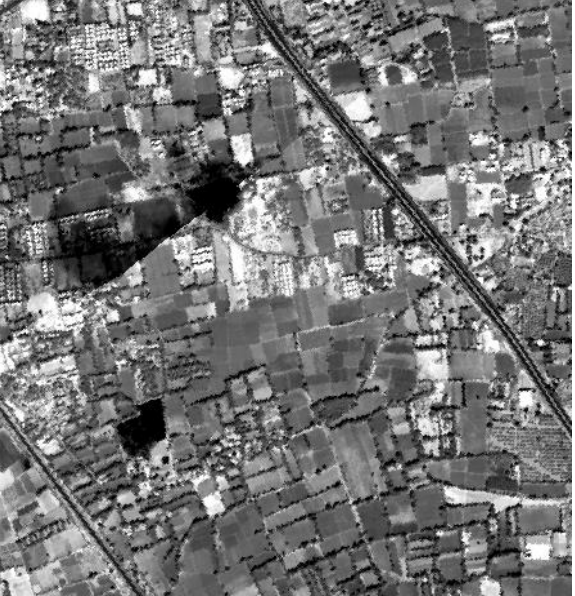
Figure 10. Band 190(SWIR) of reconstructed image without striping